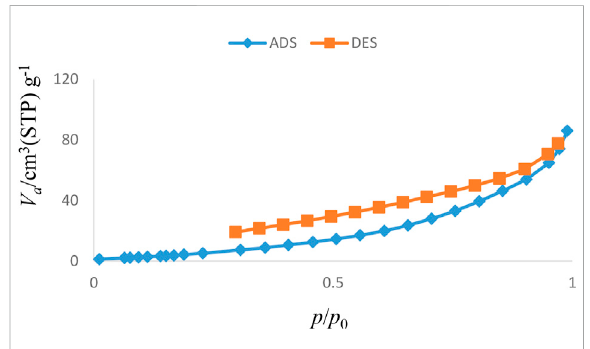
FIGURE 6 N 2 adsorption/desorption isotherms of Sc-MOF@SiO2 core/ shell nanostructures. FIGURE 7